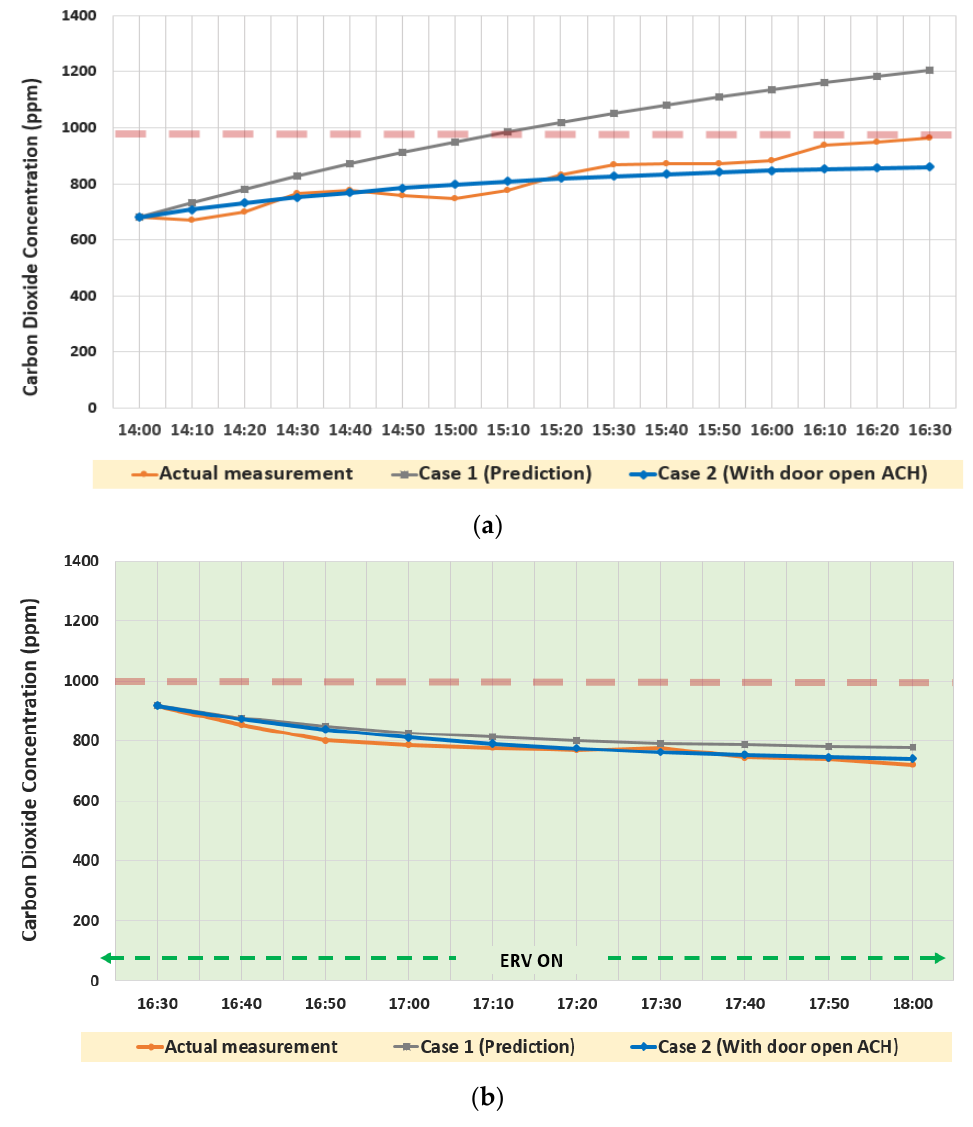
Figure 16. CO 2 comparison of the measurement and prediction tool: ( a ) with ERV off on 11 August and ( b ) with ERV in operation on 12 August.